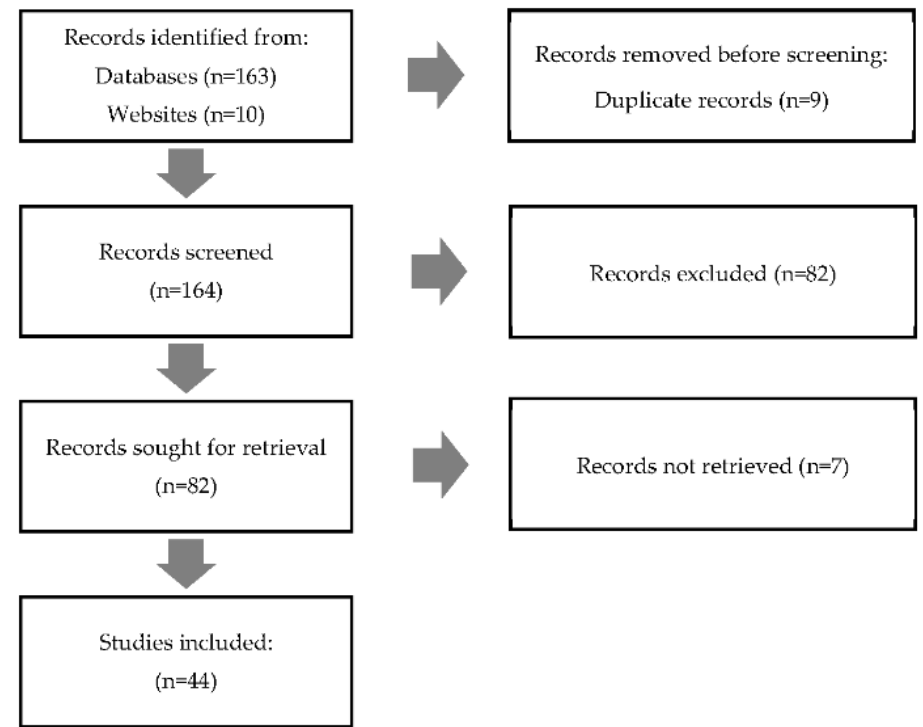
Figure 2. Flow chart of selected articles according to four different parts of the search process: identification, screening, eligibility, and inclusion.